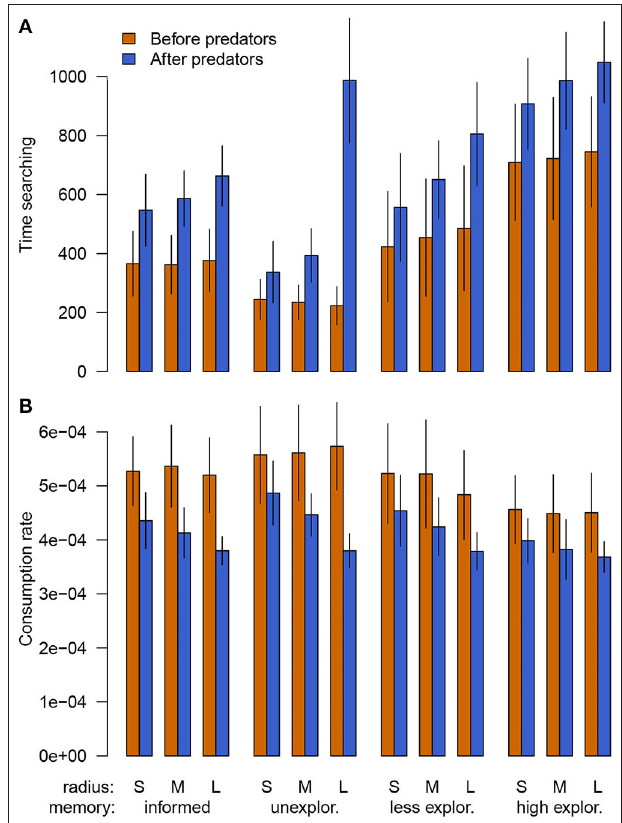
FIGURE 4 | Time budget and consumption rate before and after the introduction of predators across different values for the encounter radius (top line x -axis) and for memory state (bottom line x -axis) with lines showing the standard deviation. (A) Time spent searching as opposed to feeding (a minimal amount of time was spent in the escape behavior, mean 3–17). (B) Consumption rate while in the feeding